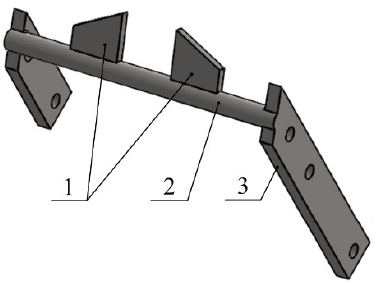
Figure 3. Spike segments: 1—spikes; 2—horizontal rod; 3—side steel strip.